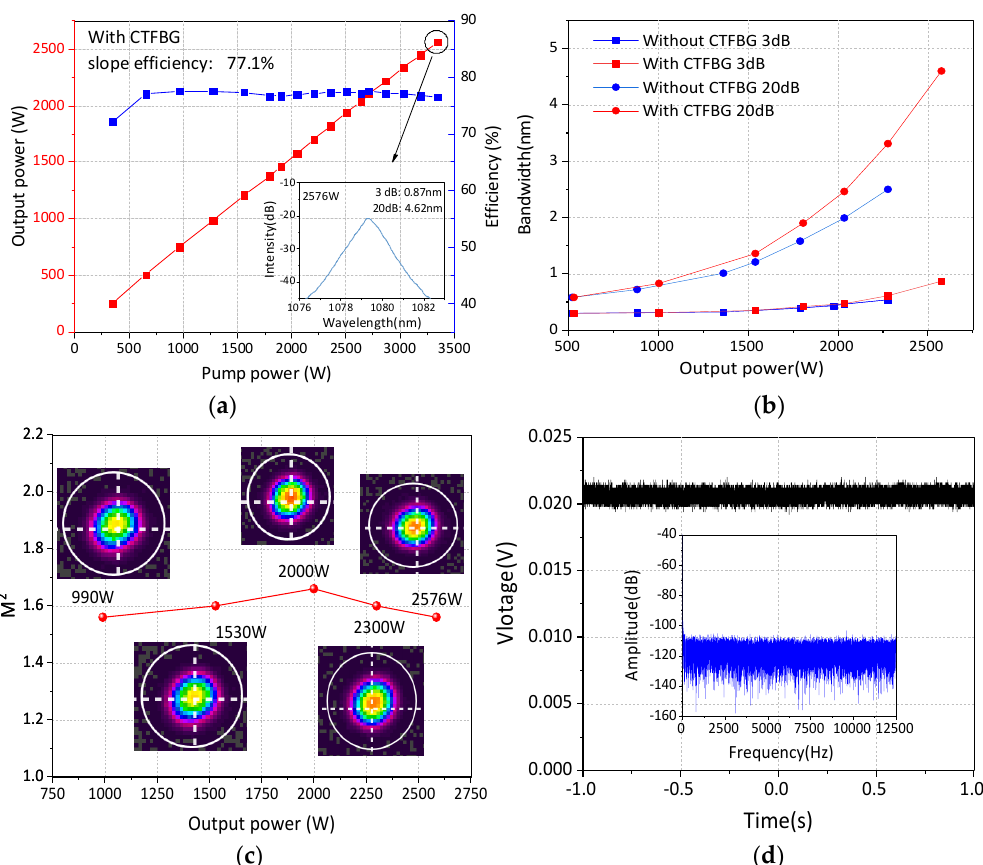
Figure 6. ( a ) The output power and optical-optical efficiency versus pump power with CTFBG. ( b ) The 3-dB and 20-dB bandwidths of the signal laser versus output laser power. ( c ) The beam quality at several output power. ( d ) Temporal signals and corresponding Fourier spectra at the output power of 2576 W.